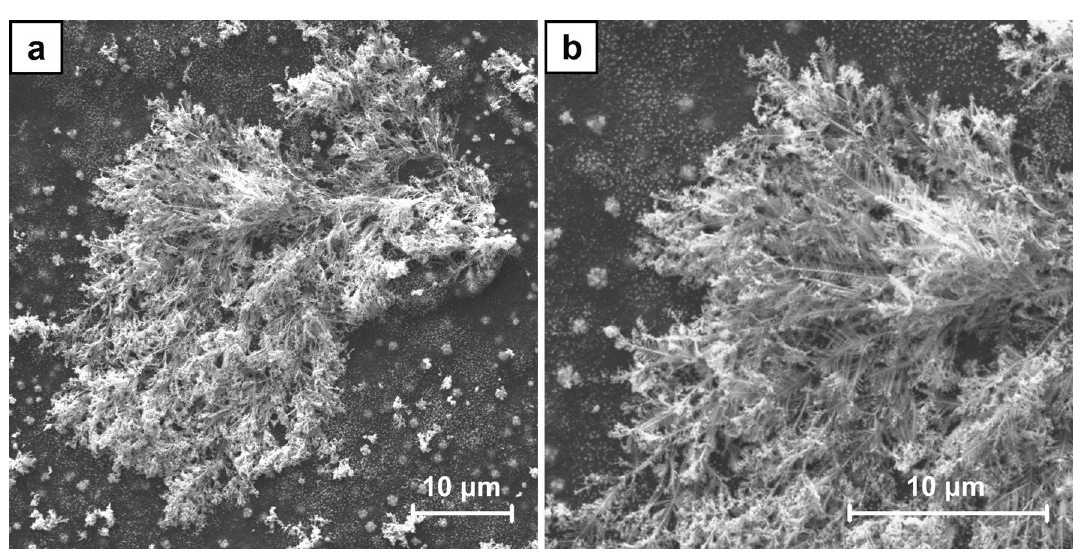
Figure 3. SEM images of the dendritic crystals formed on CNT layer in A6 sample (ECD deposition time of 450 s, CuSO 4 concentration of 1 mM) at the magnification of ×5000 ( a ) and ×10,000 ( b